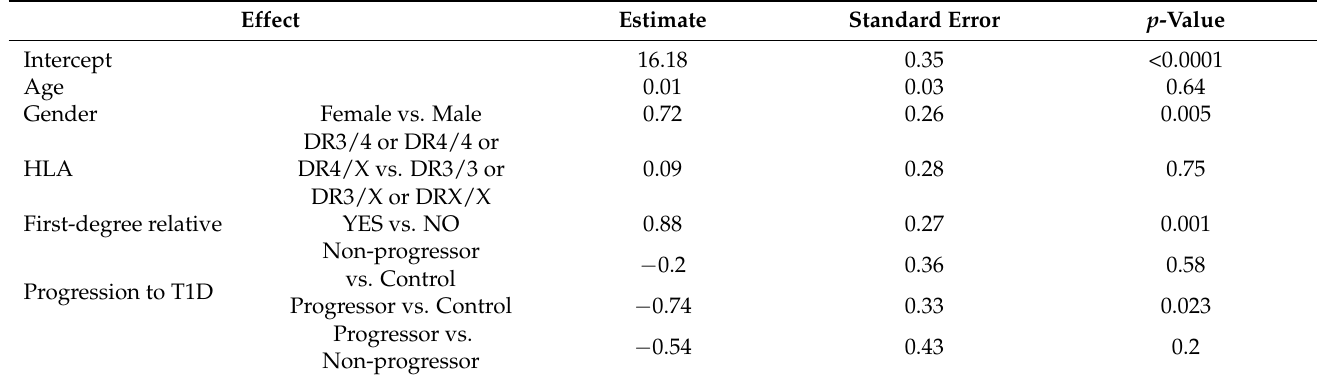
Table 2. Multivariate mixed model regression analysis of IL-1ra with age, gender, HLA type, first degree relative, and